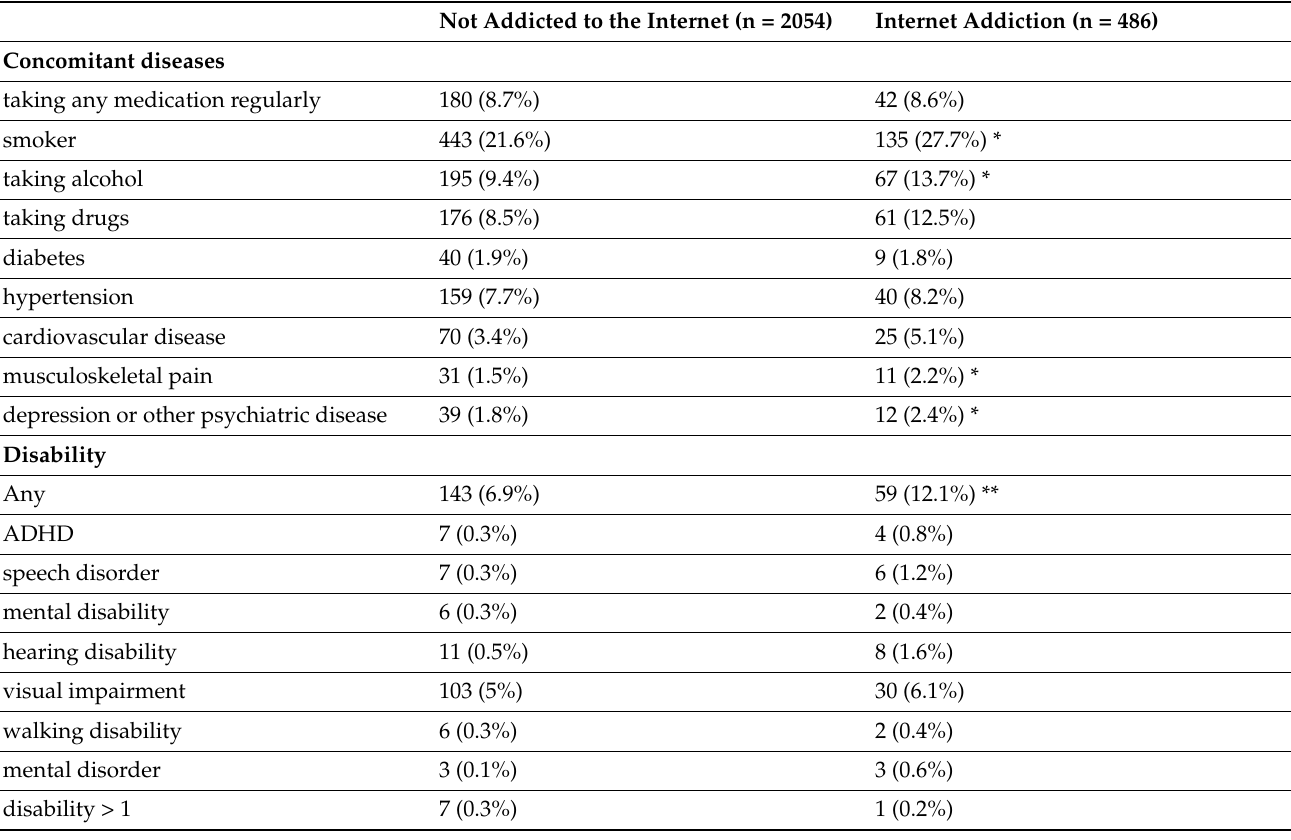
Table 5. Comparison of concomitant diseases and substance abuse and internet use in the study subgroups.